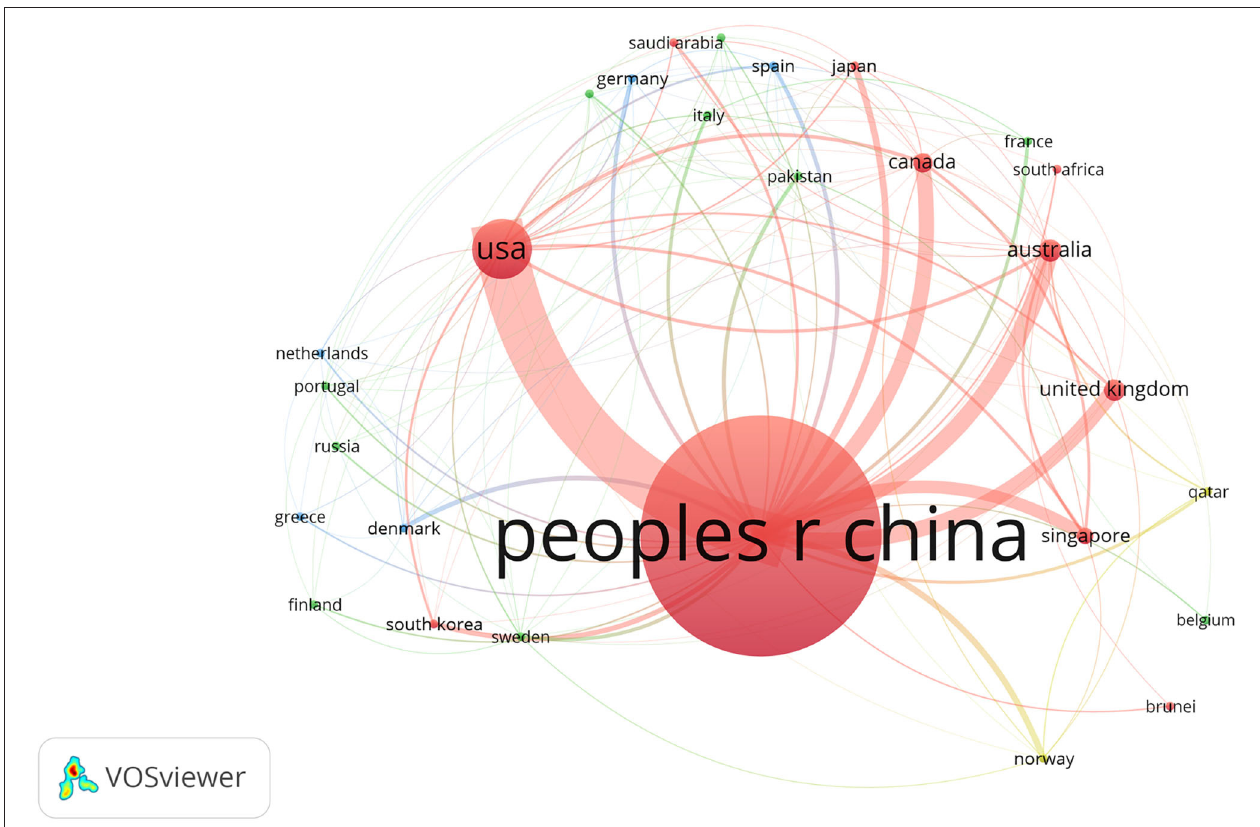
FIGURE 4 | Country co-authorship network in the field of the SG field. The larger the node is, the more papers published in cooperation between the country and China, and the thicker the connection between the nodes, the closer the cooperation between the two countries is. VOSviewer parameters: counting method: full counting, minimum occurrences 5, a total of 28 countries, normalization using LinLog/modularity method, layout parameters: attraction = 6, repulsion =